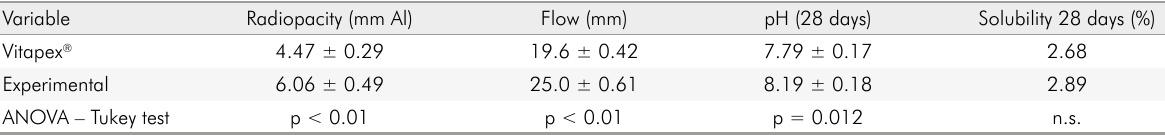
Table. Means and standard deviations of radiopacity, flow, pH, and solubility.